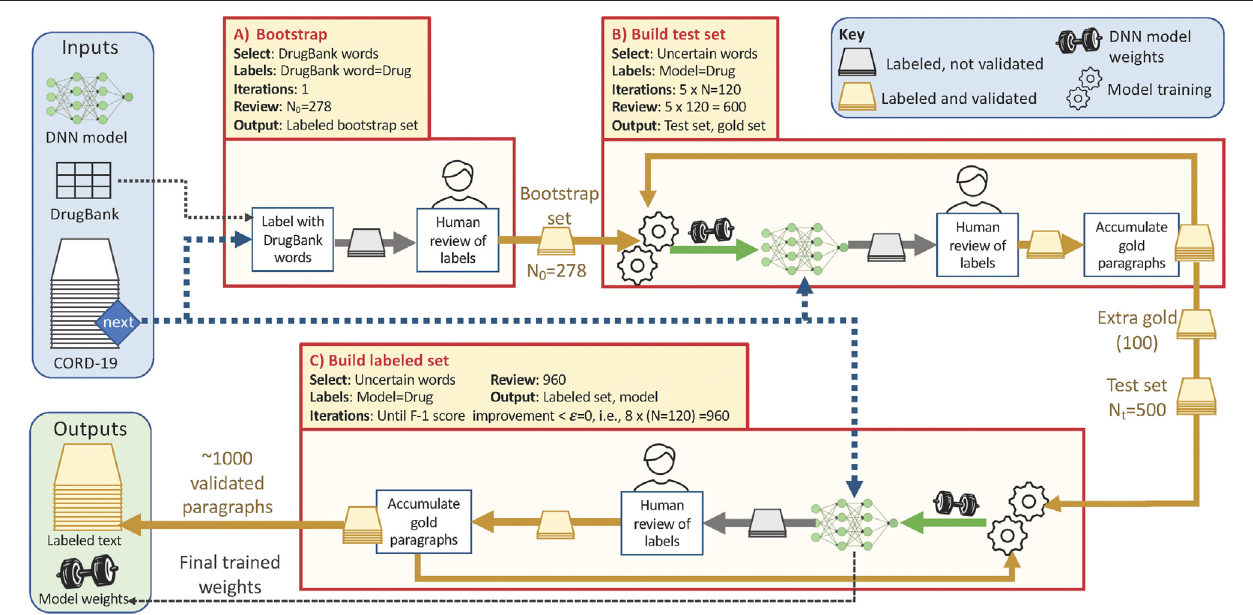
FIGURE1| Overviewofthetrainingdatacollectionwork fl ow,showingthethreephasesdescribedinthetextandwiththeparametervaluesusedinthisstudy.Each phase pulls paragraphs from the CORD-19dataset (bluedashed line) according to the Select criteria listed (yellow shaded box). PhasesB and Crepeatedly updatethe weights for the NER model (green arrows) that they use to identify and label uncertain paragraphs; human review (yellow and gold arrows) corrects those silver paragraphs to yield gold paragraphs. Total human review work is ∼ 278 + 600+960 (cid:1) 1838